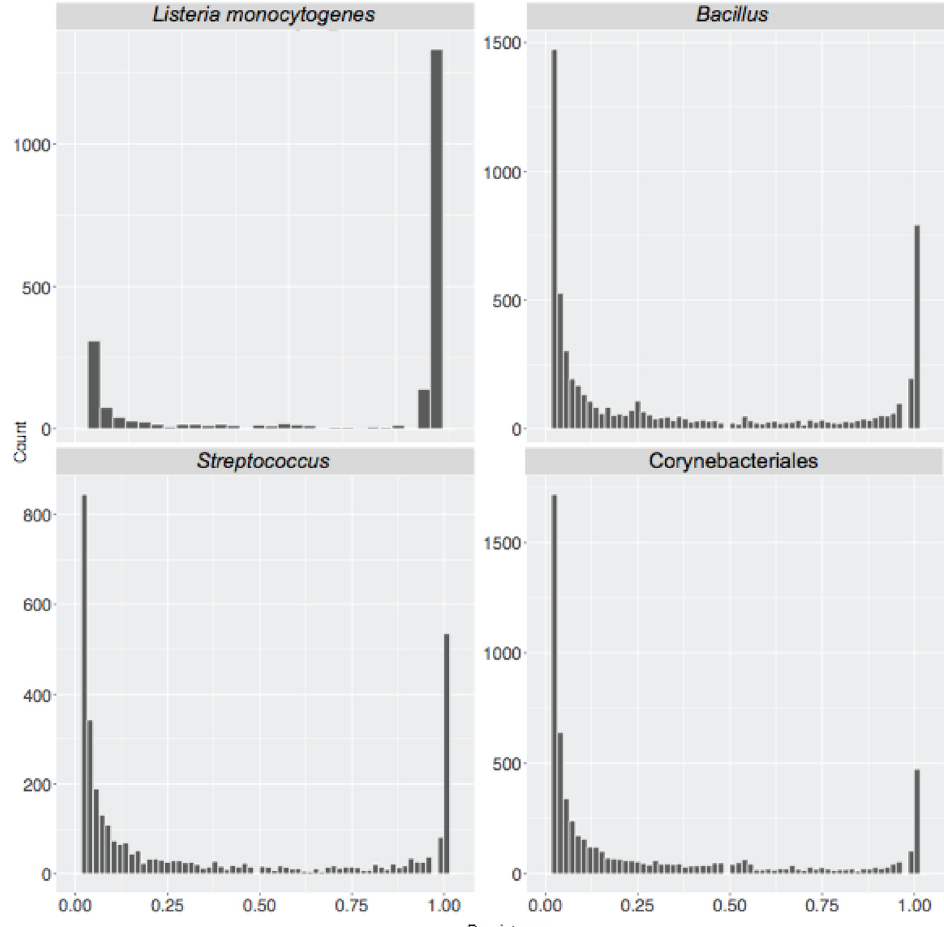
Figure 4. Persistence of domain architecture based (DAB) clusters. The frequency of DAB clusters according to their persistence is shown.